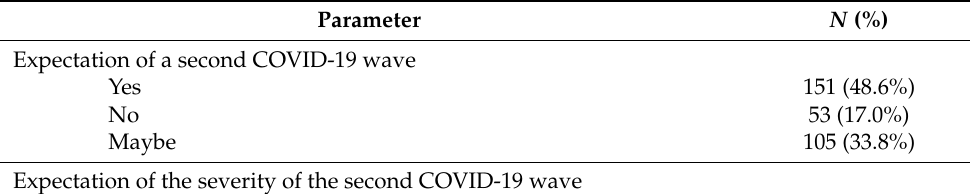
Table 3. Pharmacists’ expectations about current and future COVID-19 pandemics, ( N = 311). Parameter N